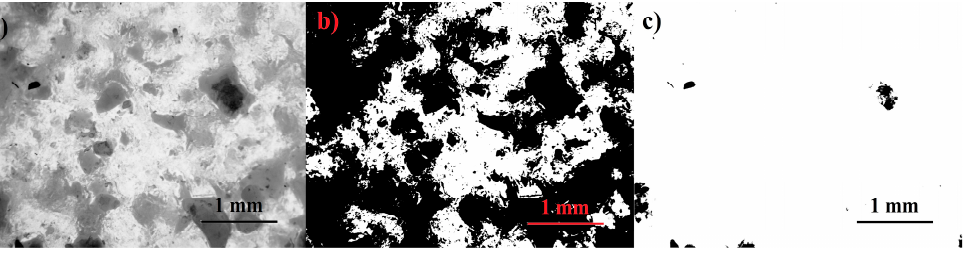
Figure 1. Images of 2nd sample ( a ) raw image from stereo microscope observations, ( b ) image after binarization with threshold of 50, and ( c ) image after binarization with threshold of 200.